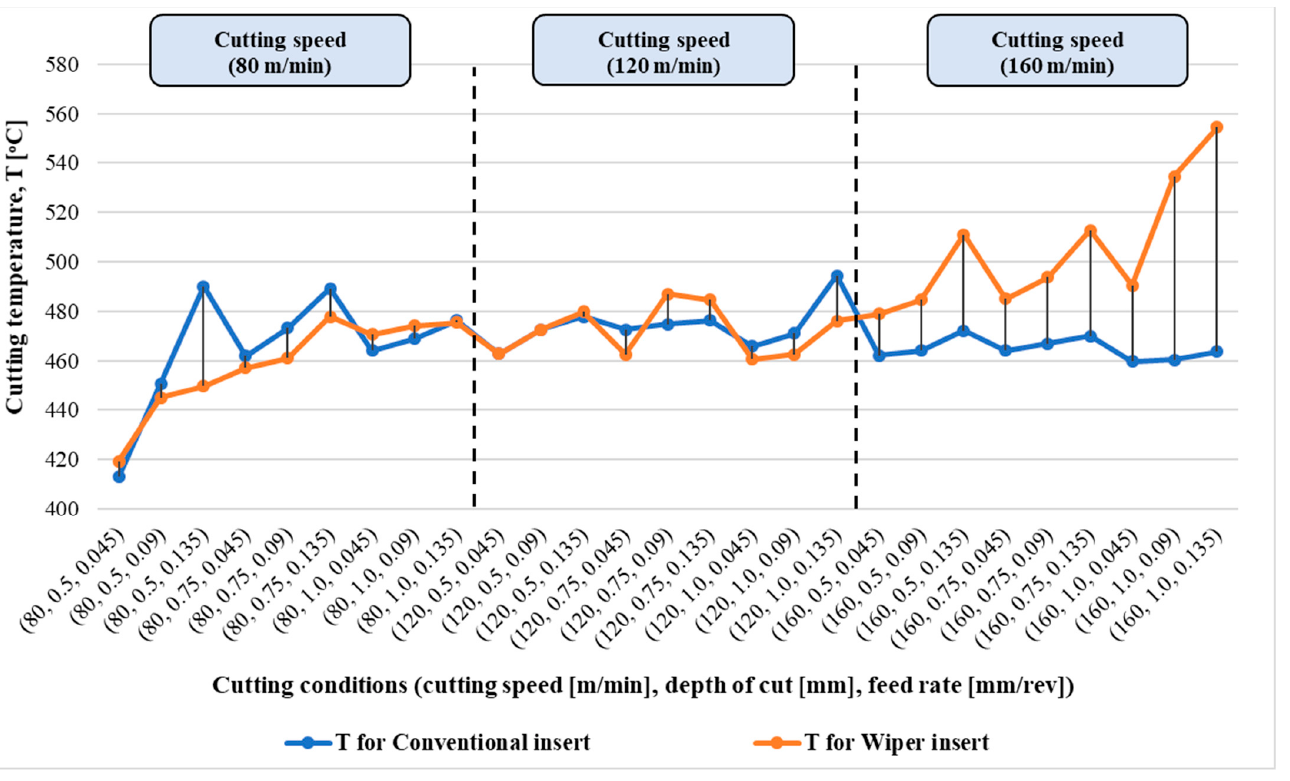
Figure 8. Cutting temperature, T in °C for both cases, of conventional and wiper inserts under a range of cutting conditions.